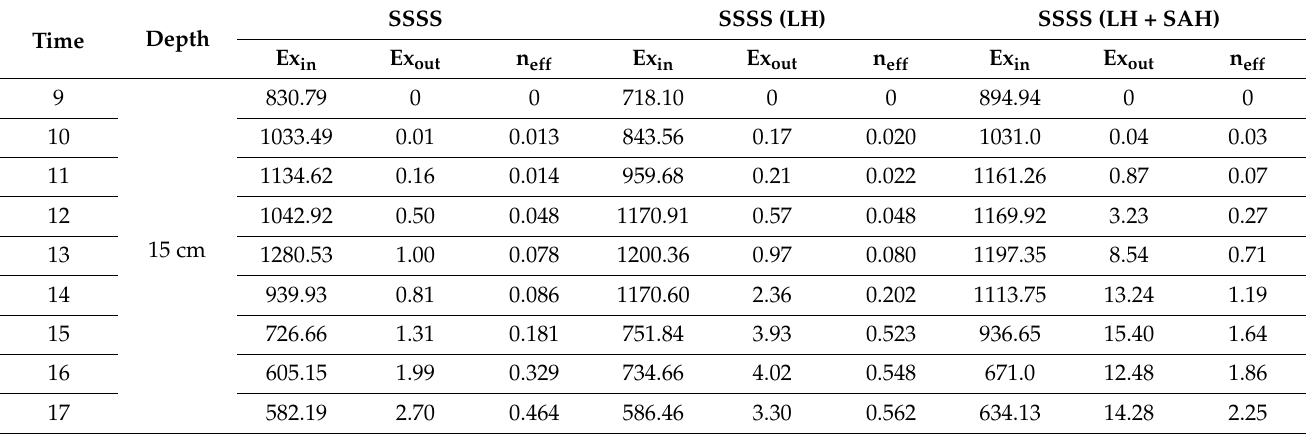
Figure 9. Variation of efficiency at different depth. Table 7. Exergy analysis of SSSS, SSSS (LH) and SSSS (LH + SAH) at the depth of 15 cm.